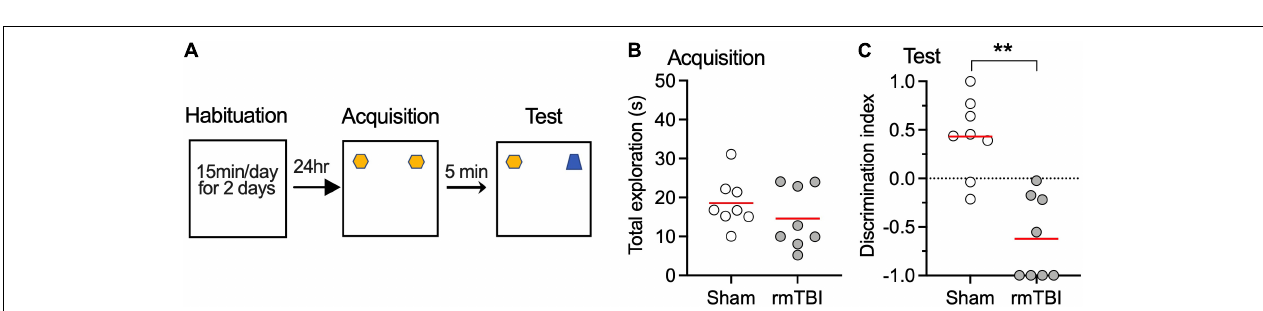
FIGURE 6 | rmTBI on rats in fear conditioning test. (A) With cued fear conditioning, rats with sham injury and rmTBI show similar learning. (B) Rats with rmTBI show impaired memory in cued fear condition. (C,D) Rats with rmTBI show faster extinction of cued fear memory in 4 days test without presence of shock. * P < 0.05 by the t -test. With trace fear conditioning, using a delayed unconditional stimulus (US, paw shock) after conditional stimulus (CS, tone), rats with rmTBI and Sham rats show comparable learning (E) , and memory (F,G) . Each dot represents data from one animal.